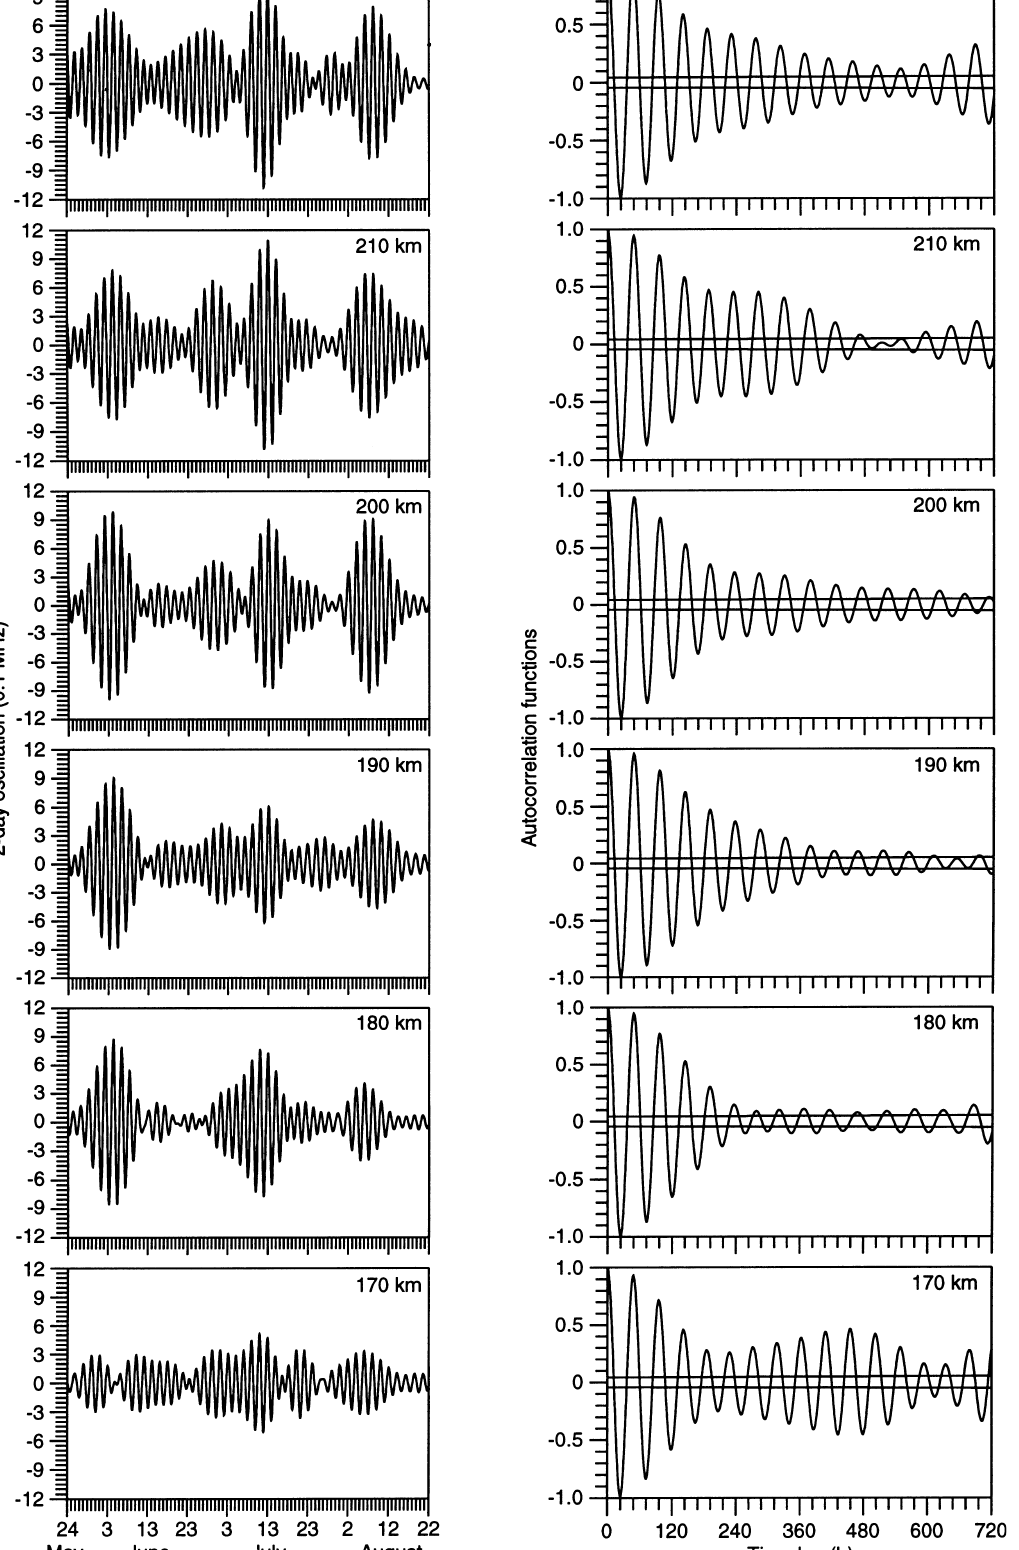
correlation functions of the filtered data ( heavy lines ) and their corresponding 95% confidence levels ( thin lines ) for the same